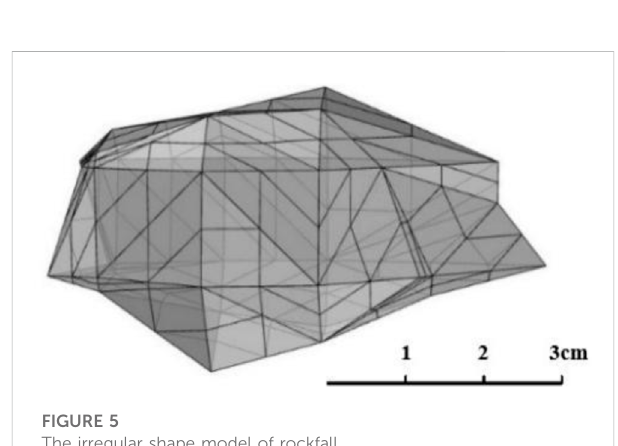
FIGURE 5 The irregular shape model of